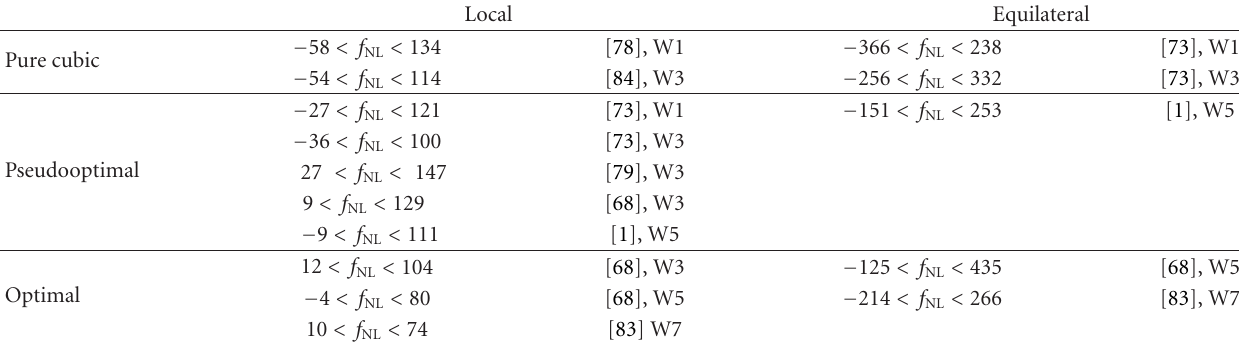
Table 3: Constraints on f local , f equil. , obtained by di ff erent groups on the one-year (W1), three-year (W3), five-year (W5), and seven-year NL NL (W7) WMAP data releases. Di ff erent rows correspond to the di ff erent implementations of the f NL estimator described in the text: the “pure cubic” implementation (99) in which no linear term is included, the “pseudooptimal” implementation (113) in which a linear term is added but the covariance matrix is assumed to be diagonal in the cubic term, and the fully “optimal” implementation (97). As we noted in the text, the linear term is important mostly for estimates of local NG, since anisotropic noise “mimics” squeezed configuration. For this